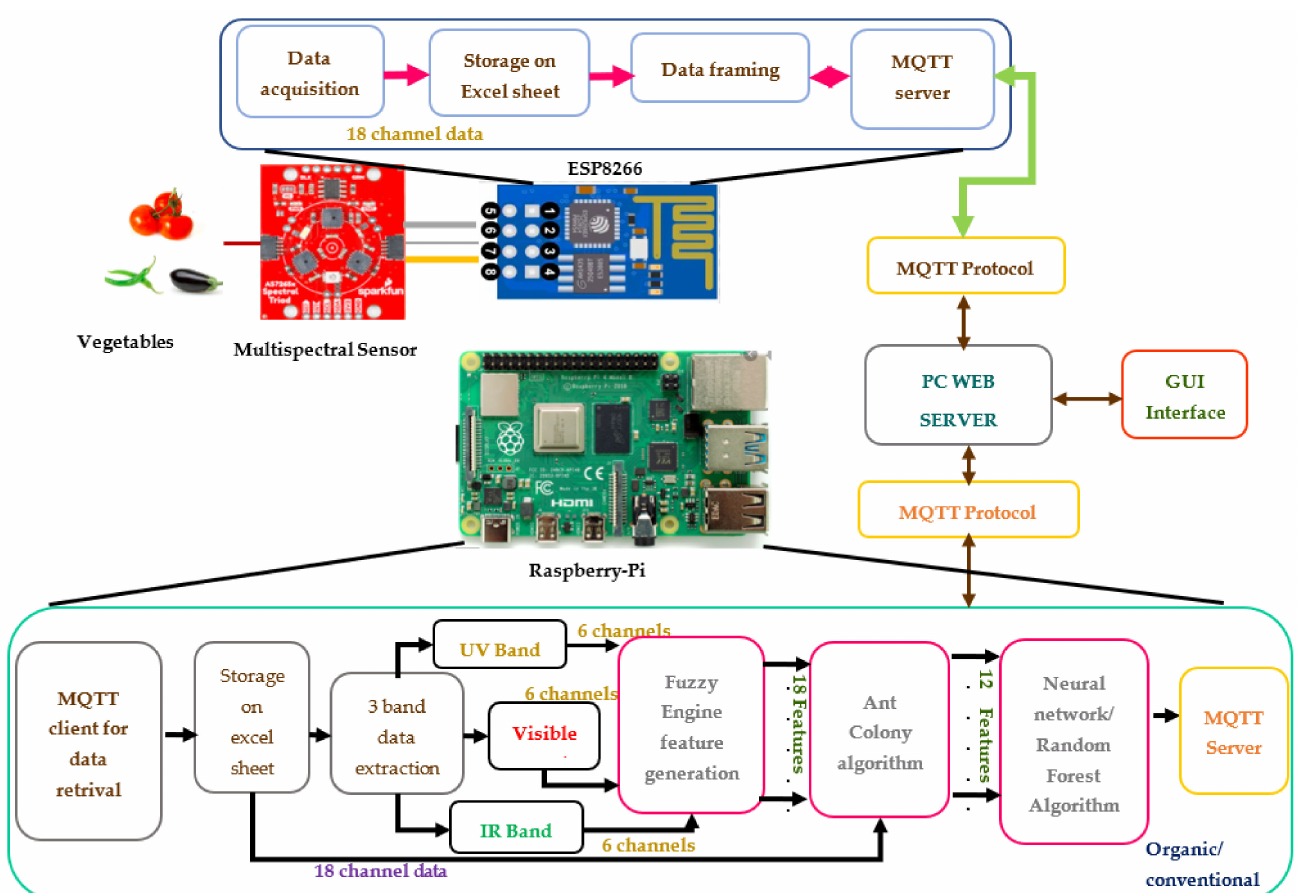
Figure 1. Block diagram of artificial intelligence (AI)-enabled organic and conventional discrimination using IoT